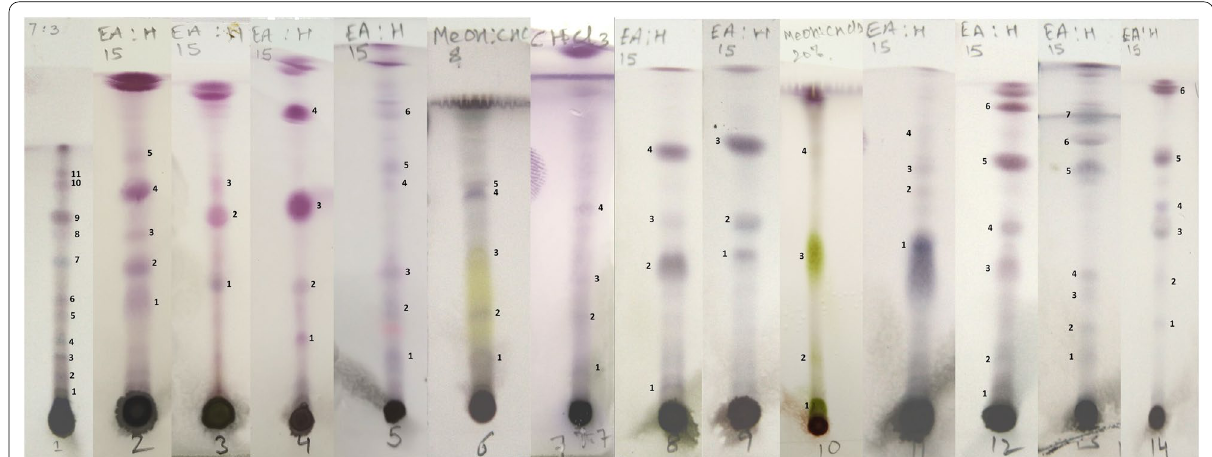
Fig. 6 TLC profiles of root crude extracts of 14 species of Apocynaceae (TLC profiles numbered from 1 to 14 represent species A. curassavica to T. divaricata